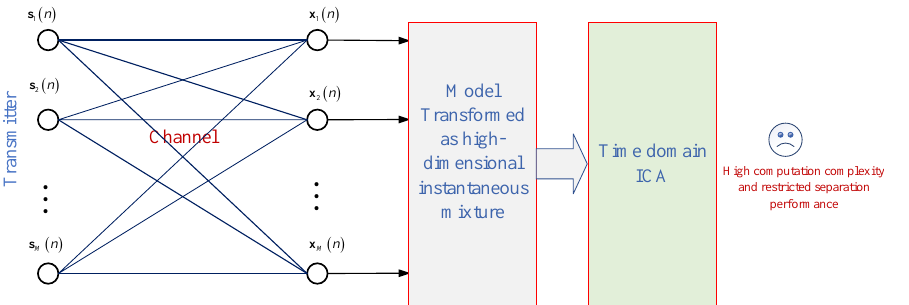
Figure 1. Convolutive mixture model with time-domain ICA detection